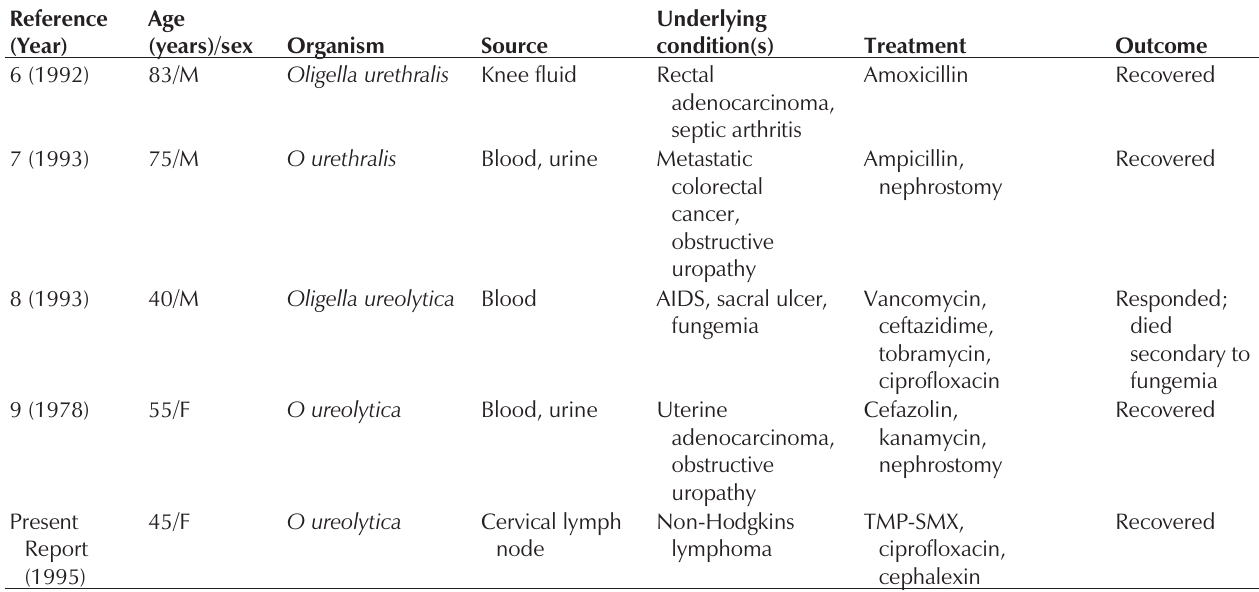
Clinical features of reported cases of oligella infection Reference